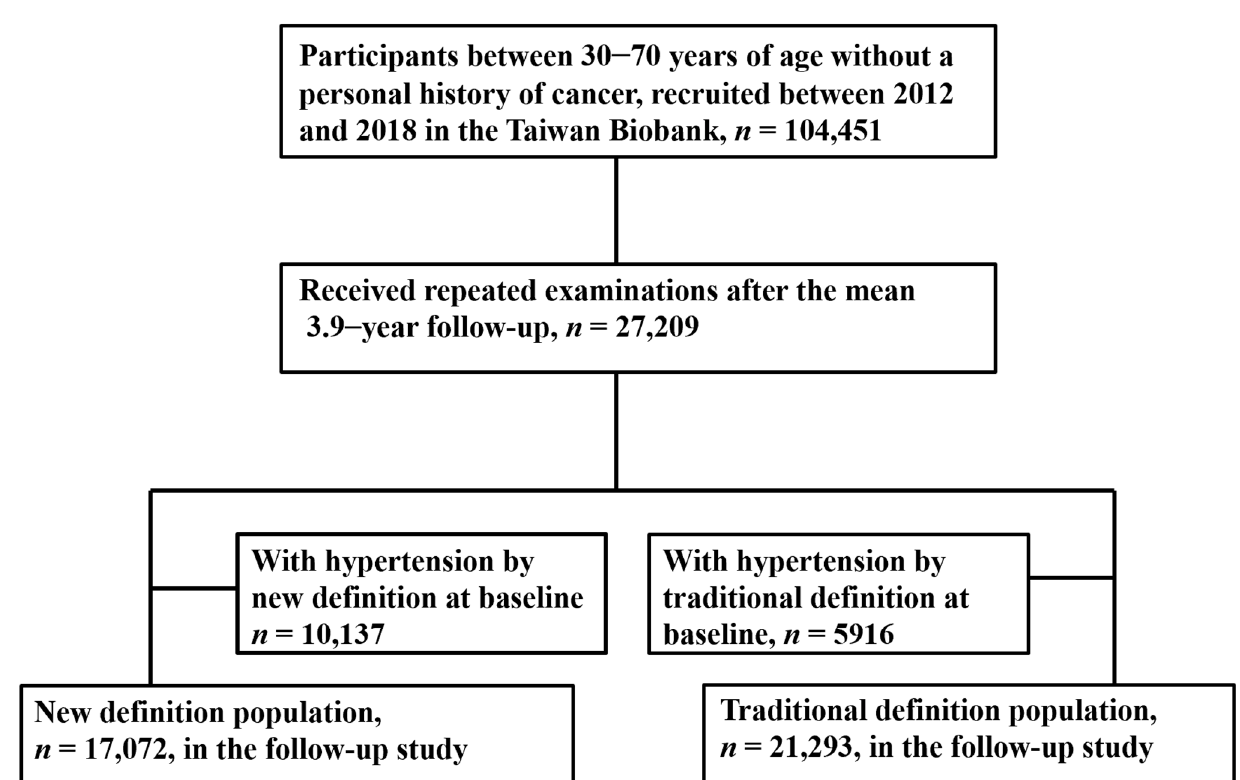
Figure 1. Flowchart of study population.